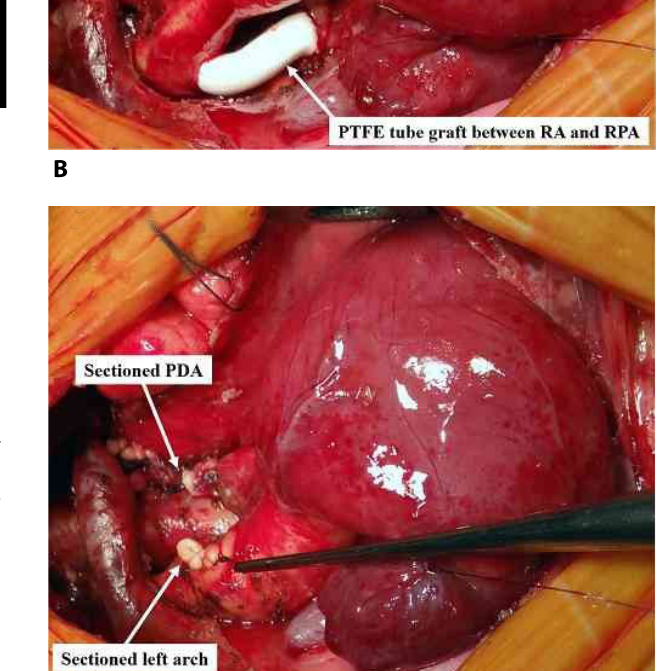
compression presumed after surgical evaluation.